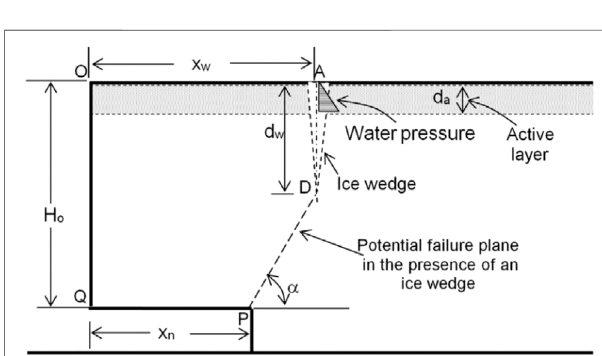
FIGURE 4 | Sketch of the bluff cross-section assumed by Hoque and Pollard (2016) in their analysis of overturning failure.